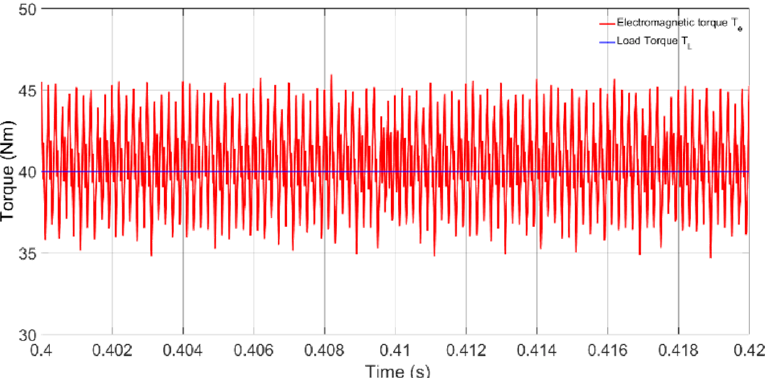
Figure 6. Torque waveform with 40 Nm for cSVM-DTC1 (10 kHz).